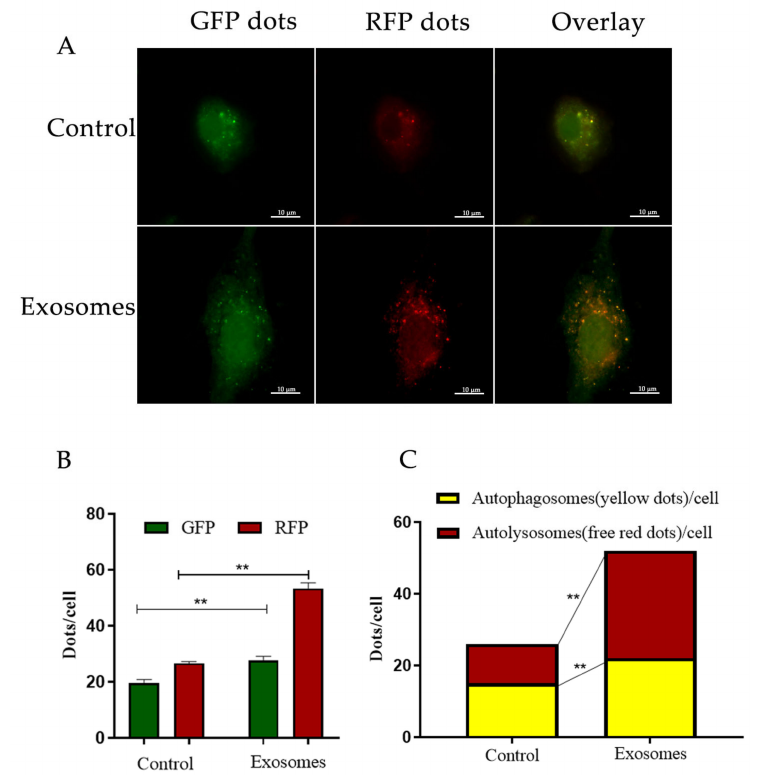
Figure 4. Enhanced autophagy flux of YFFEVs in YCCs. ( A ) Confocal imaging of YCCs with YFFEVs treatments after RFP-GFP-LC3 transfection. Scale bar represents 10 µ m. ( B ) Quantitative analysis of GFP and RFP dots. Green dots represent autophagosomes, and red dots represent autophago- somes and autolysosomes. ( C ) The quantitative analysis of merged images with both yellow dots (autophagosomes) and red dots (autolysosomes). Data are expressed as the mean ± SD. n = 6. NS means no significant difference. ** p < 0.01 indicates a significant difference between the yak follicular fluid exosome treatments and the